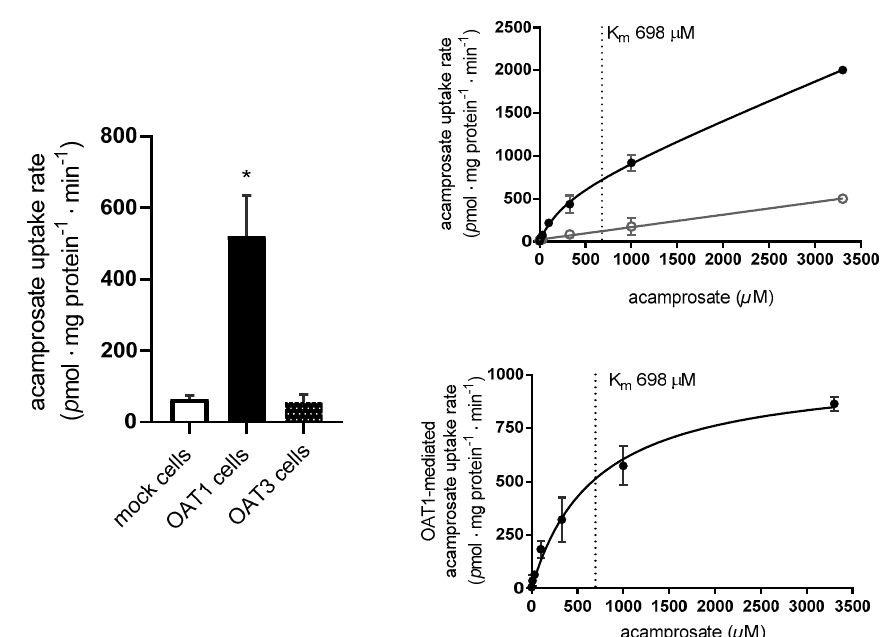
Figure 6. Evaluating acamprosate as a substrate for OAT1 / 3. ( A ) Uptake of 200 µ M acamprosate measured for 10 min in HEK293-Flp-In mock, OAT1, and OAT3 cells. Differences as compared with the uptake rate in mock are indicated (* p ≤ 0.05). ( B ) The concentration-dependent uptake rate of 0.02 – 3300 µ M acamprosate measured for 10 min in HEK293-Flp-In OAT1 cells (black closed circles) and Flp-In mock cells (grey open circles). ( C ) The OAT1-mediated uptake rate of 0.02 – 3300 µ M acamprosate. Each data point represents the mean ± SEM obtained in three cell passages at Lab. 1.